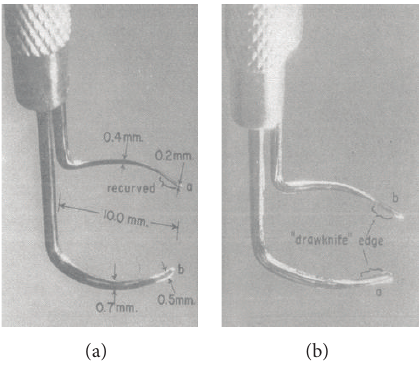
Figure 2: Two varieties of rigid probes as described by Allen and Burian and used in sector trabeculotomy. The probe on the left has a blunt tip, while the one on the right is fitted with a drawknife edge [11].